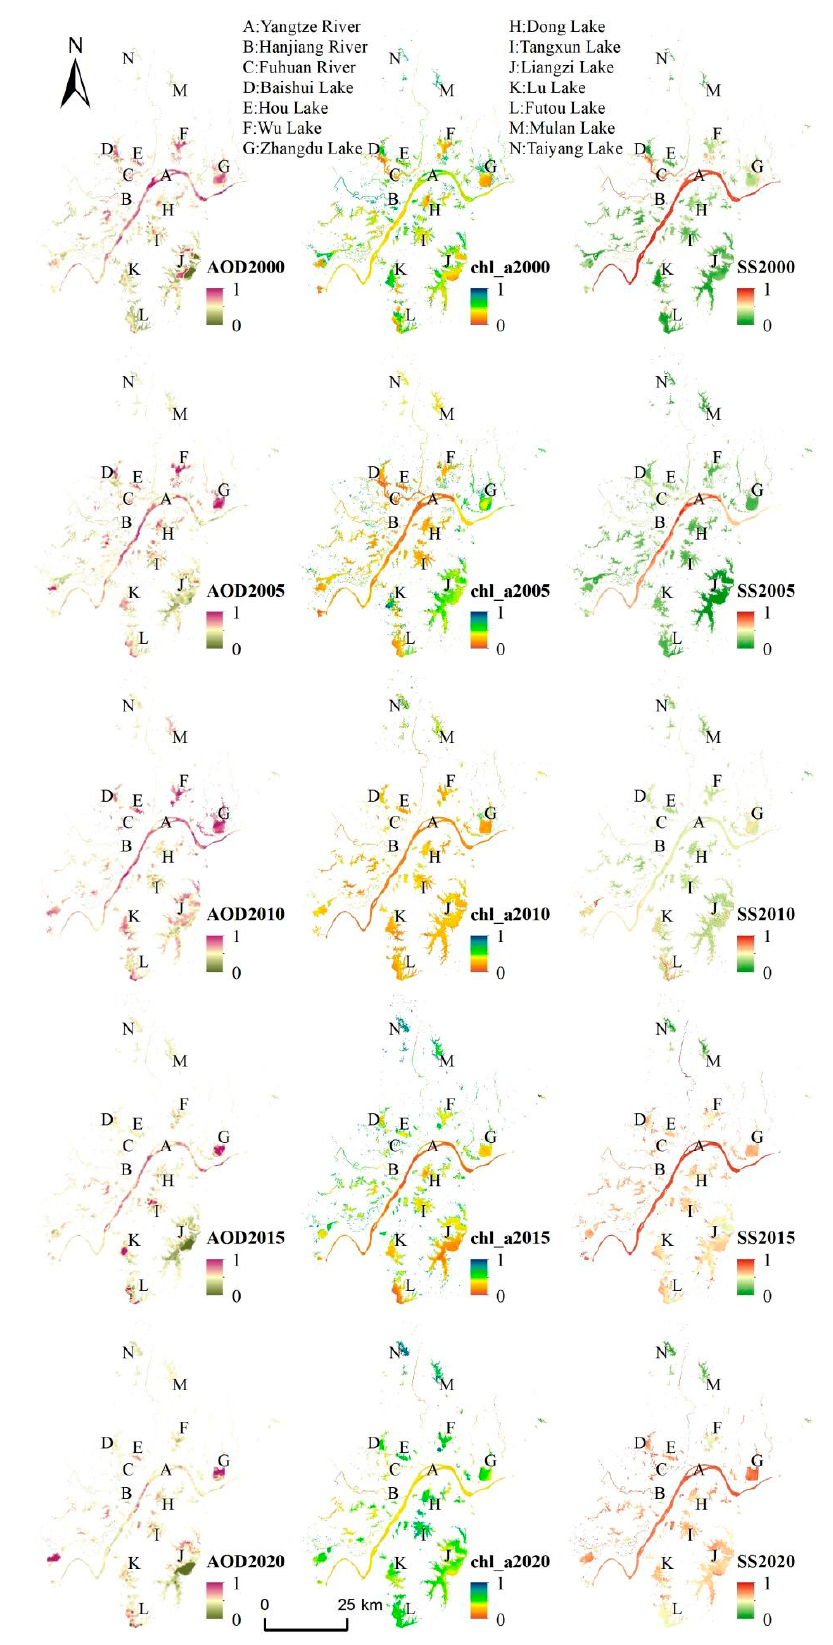
Figure 4. Spatial distribution of the ecological indicators in the water region.